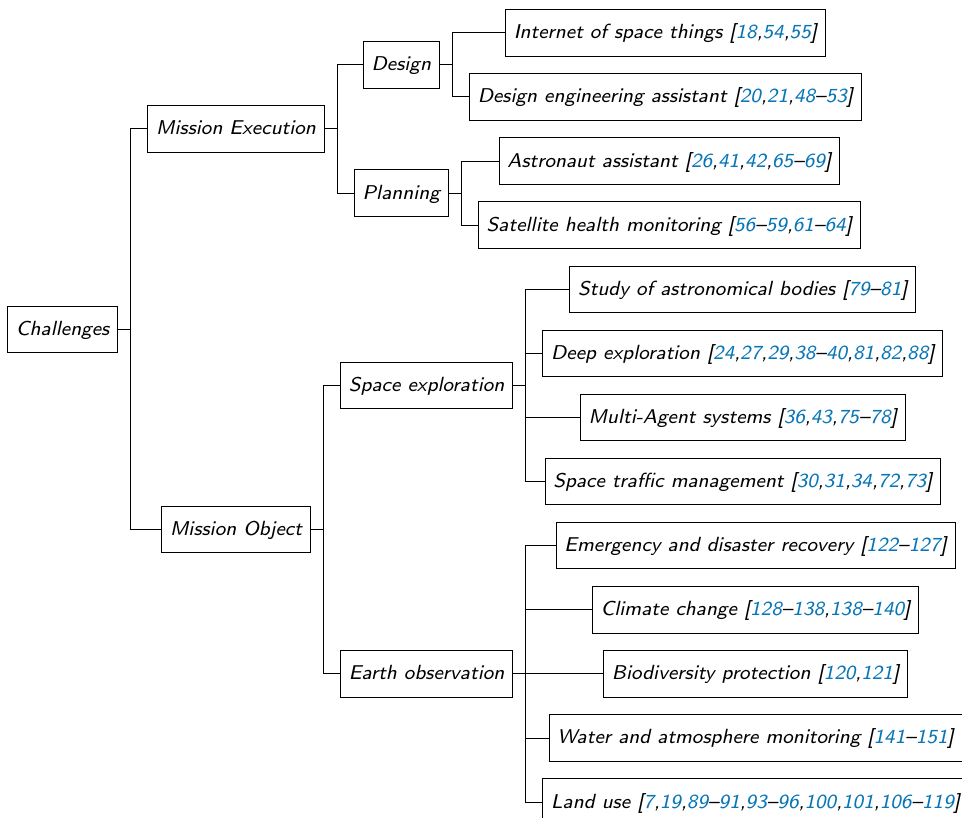
Figure 1. Challenges in Space